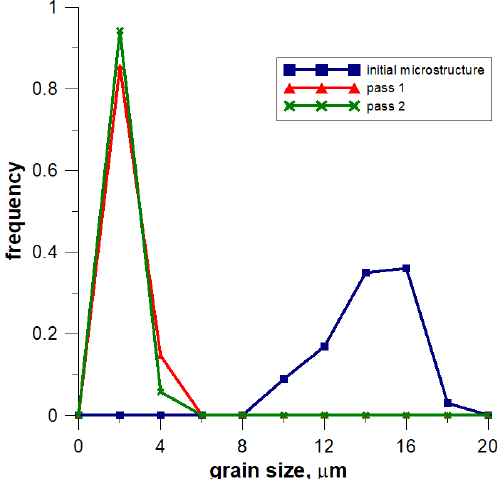
Figure 26. Average grain size – time ( a ) and flow stress – time ( b ) changes during shape rolling.